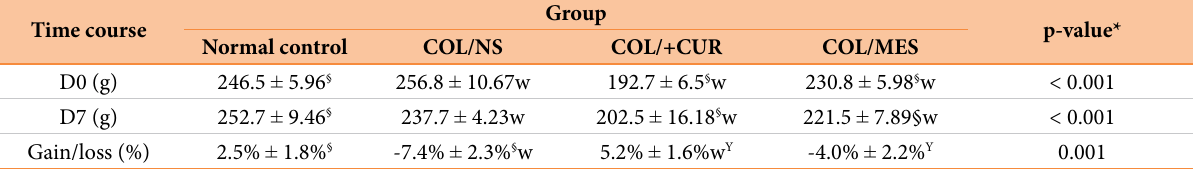
Table 1 - Results of the body weight of the animals, comparing day zero (D0) and day 7 (D7) of the experiments # .